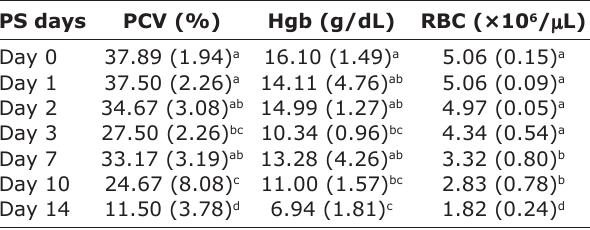
Table-1: Changes in the mean PCV, Hgb, and RBC of CPDA-1 SCB PS of blood.